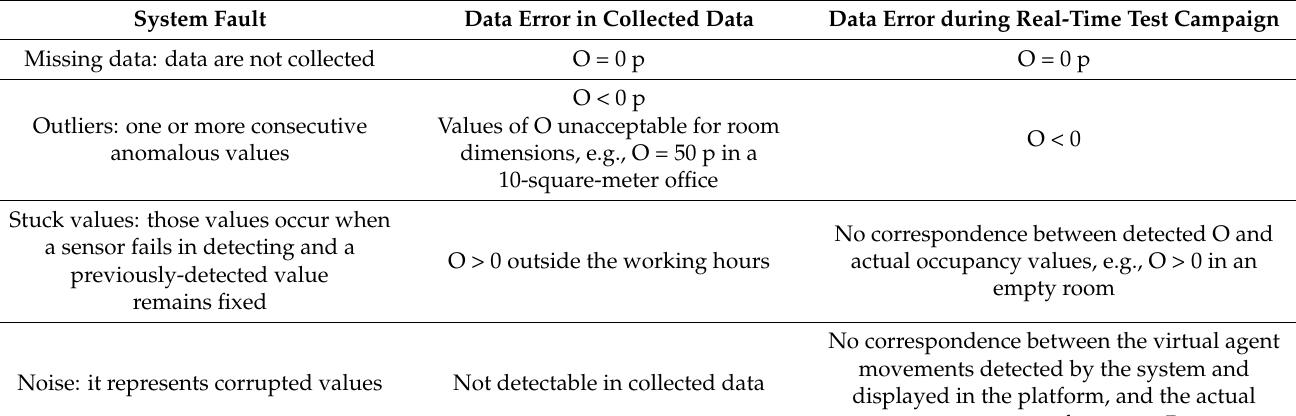
Table 2. System faults [22] and related data errors. Data errors are divided into errors observed in collected data and errors detected during real-time test